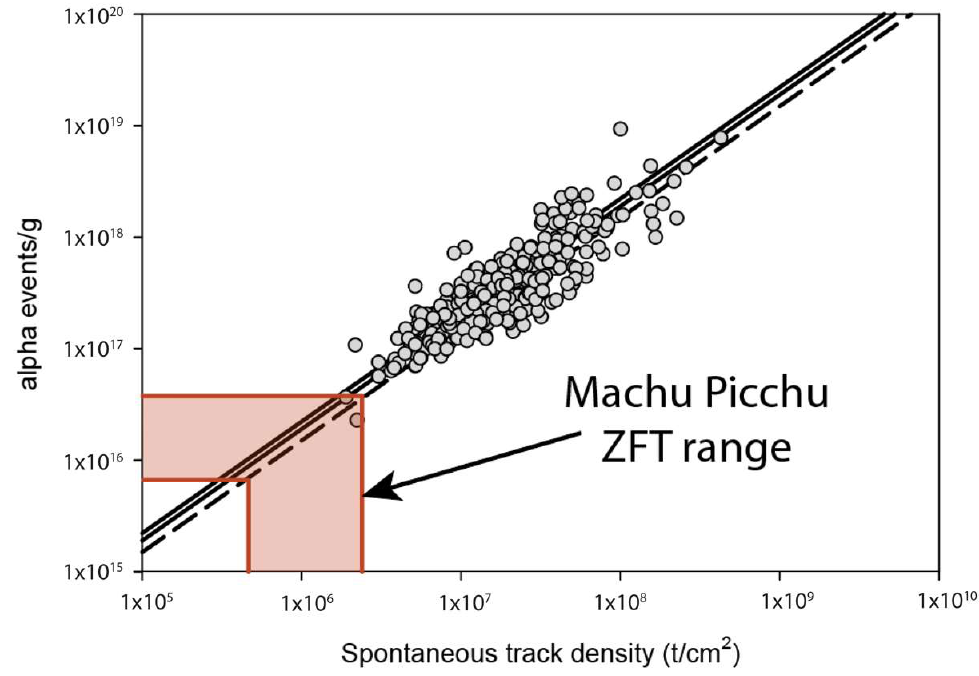
Figure 6. Plot of the Machu Picchu ZFT data (light red area) in the simplified spontaneous track density ( ρ s ) and α -dose relationship from [45]. Grey dots are the 336 zircons they analyzed, and the dashed and full lines represent the approximate and full relationships they computed, respectively. Spontaneous track densities from the Machu Picchu zircons indicate α -doses below 4 × 10 16 α Table 4. Closure temperature (Tc) estimation with a scenario implying rapid cooling initiated be- tween 5 and 7 Ma (case 1) and a simple scenario where the α-dose received is only due to the age of the Permo-Triasic, pluton 222 Ma; [23], (case 2) or of a >1 Ga pluton (case 3). Tc is estimated for each aliquot by reporting the computed α-dose for each case in Figure 8.